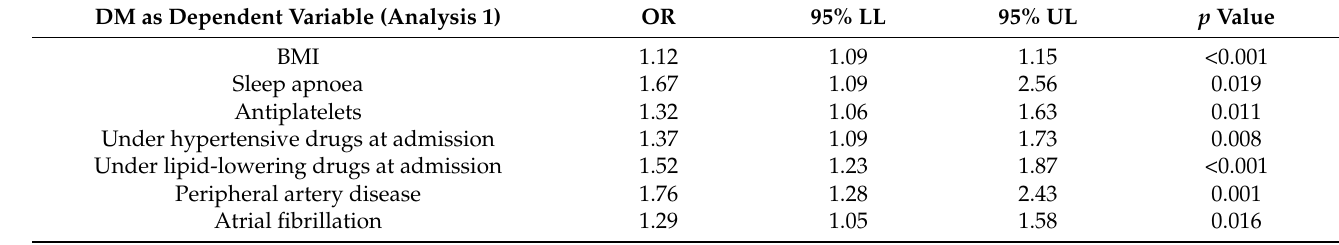
Table 2. Multivariable analyses with DM (analysis 1), common carotid artery pulsatility index (analysis 2a) and intima-media thickness (analysis 2b) as the dependant variables,